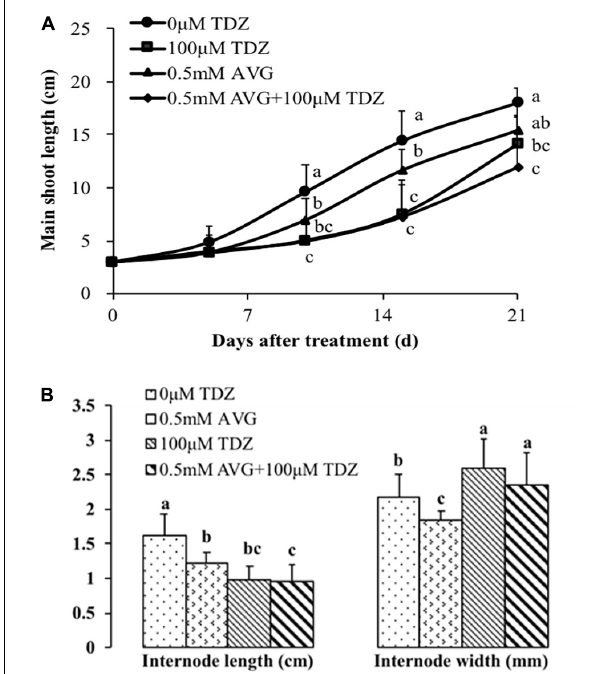
FIGURE 8 | Effects of ethylene action inhibitor STS and TDZ applications alone and together on the main shoot length measured on 1, 2, and 3 weeks (A) , and third internode length and thickness (width) measured after 2 weeks (B) of potted miniature rose plants. Means ( ± SE, n = 16) within days (A) and length or thickness (B) with different letters are significantly different at P ≤ 0.05.